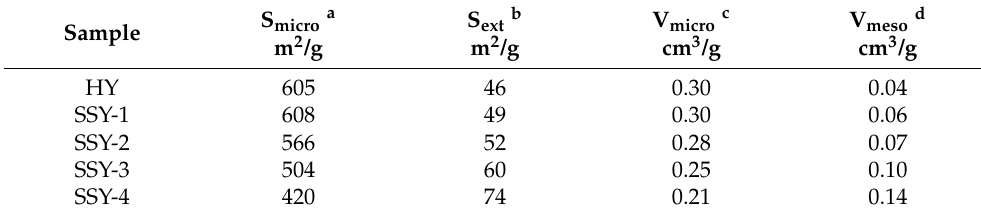
Figure 2. Pore size distributions of the modified and parent zeolites.